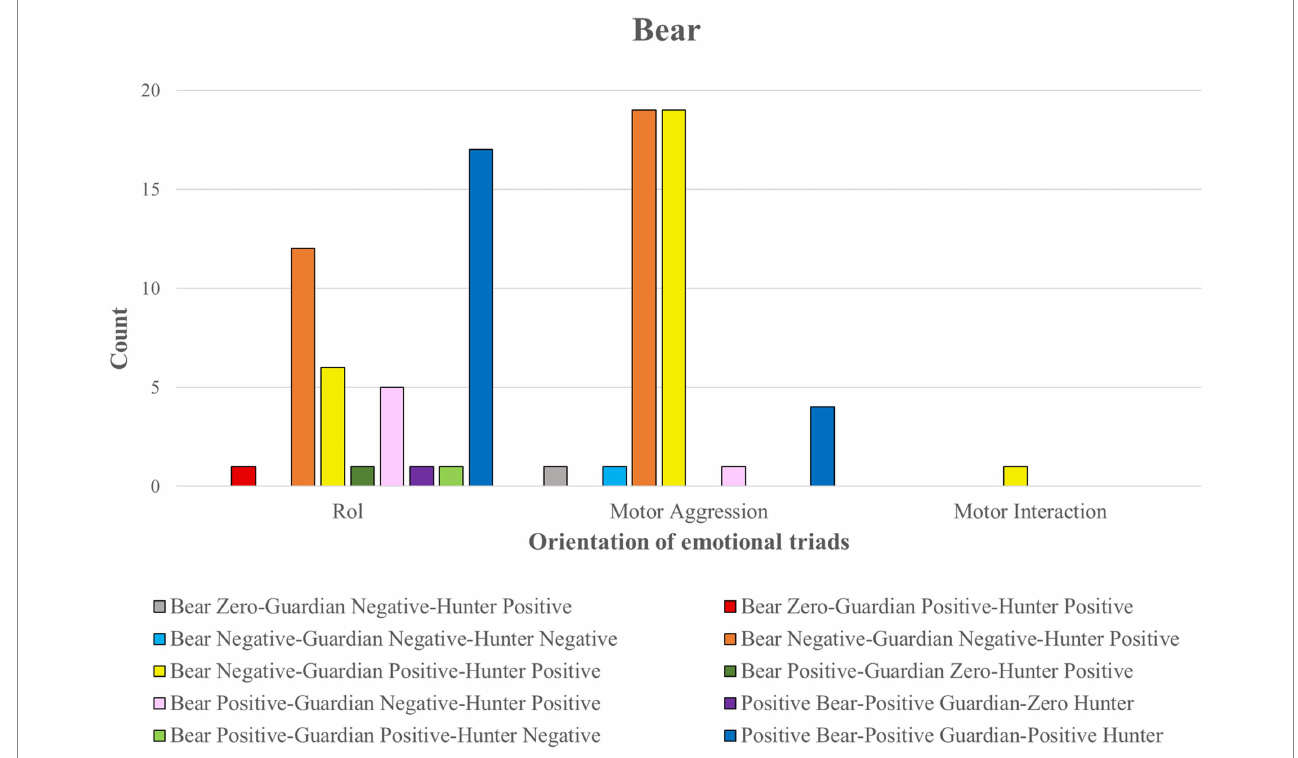
FIGURE 7 The intensity of positive and negative emotions in the Bear, Guardian, and Hunter